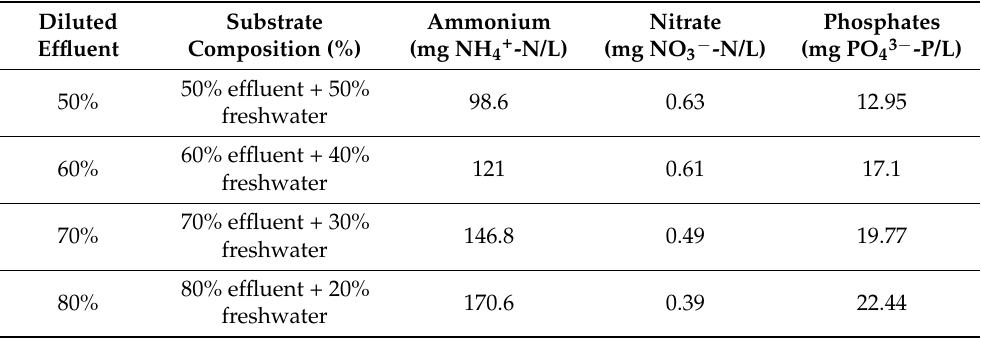
Table 3. Nutrients (N-NH 4+ , N-NO 3 − , and P-PO 43 − ; mg L − 1 ) content of winter-season centrate after filtration and dilution with freshwater (50, 60, 70, and 80% centrate in freshwater). In all cases, N to P molar ratio was about